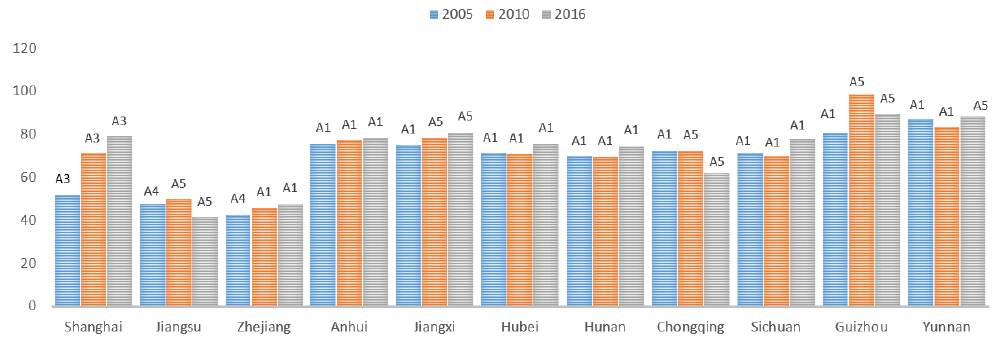
Figure 5. Substance factors and obstacles of CERC (%).